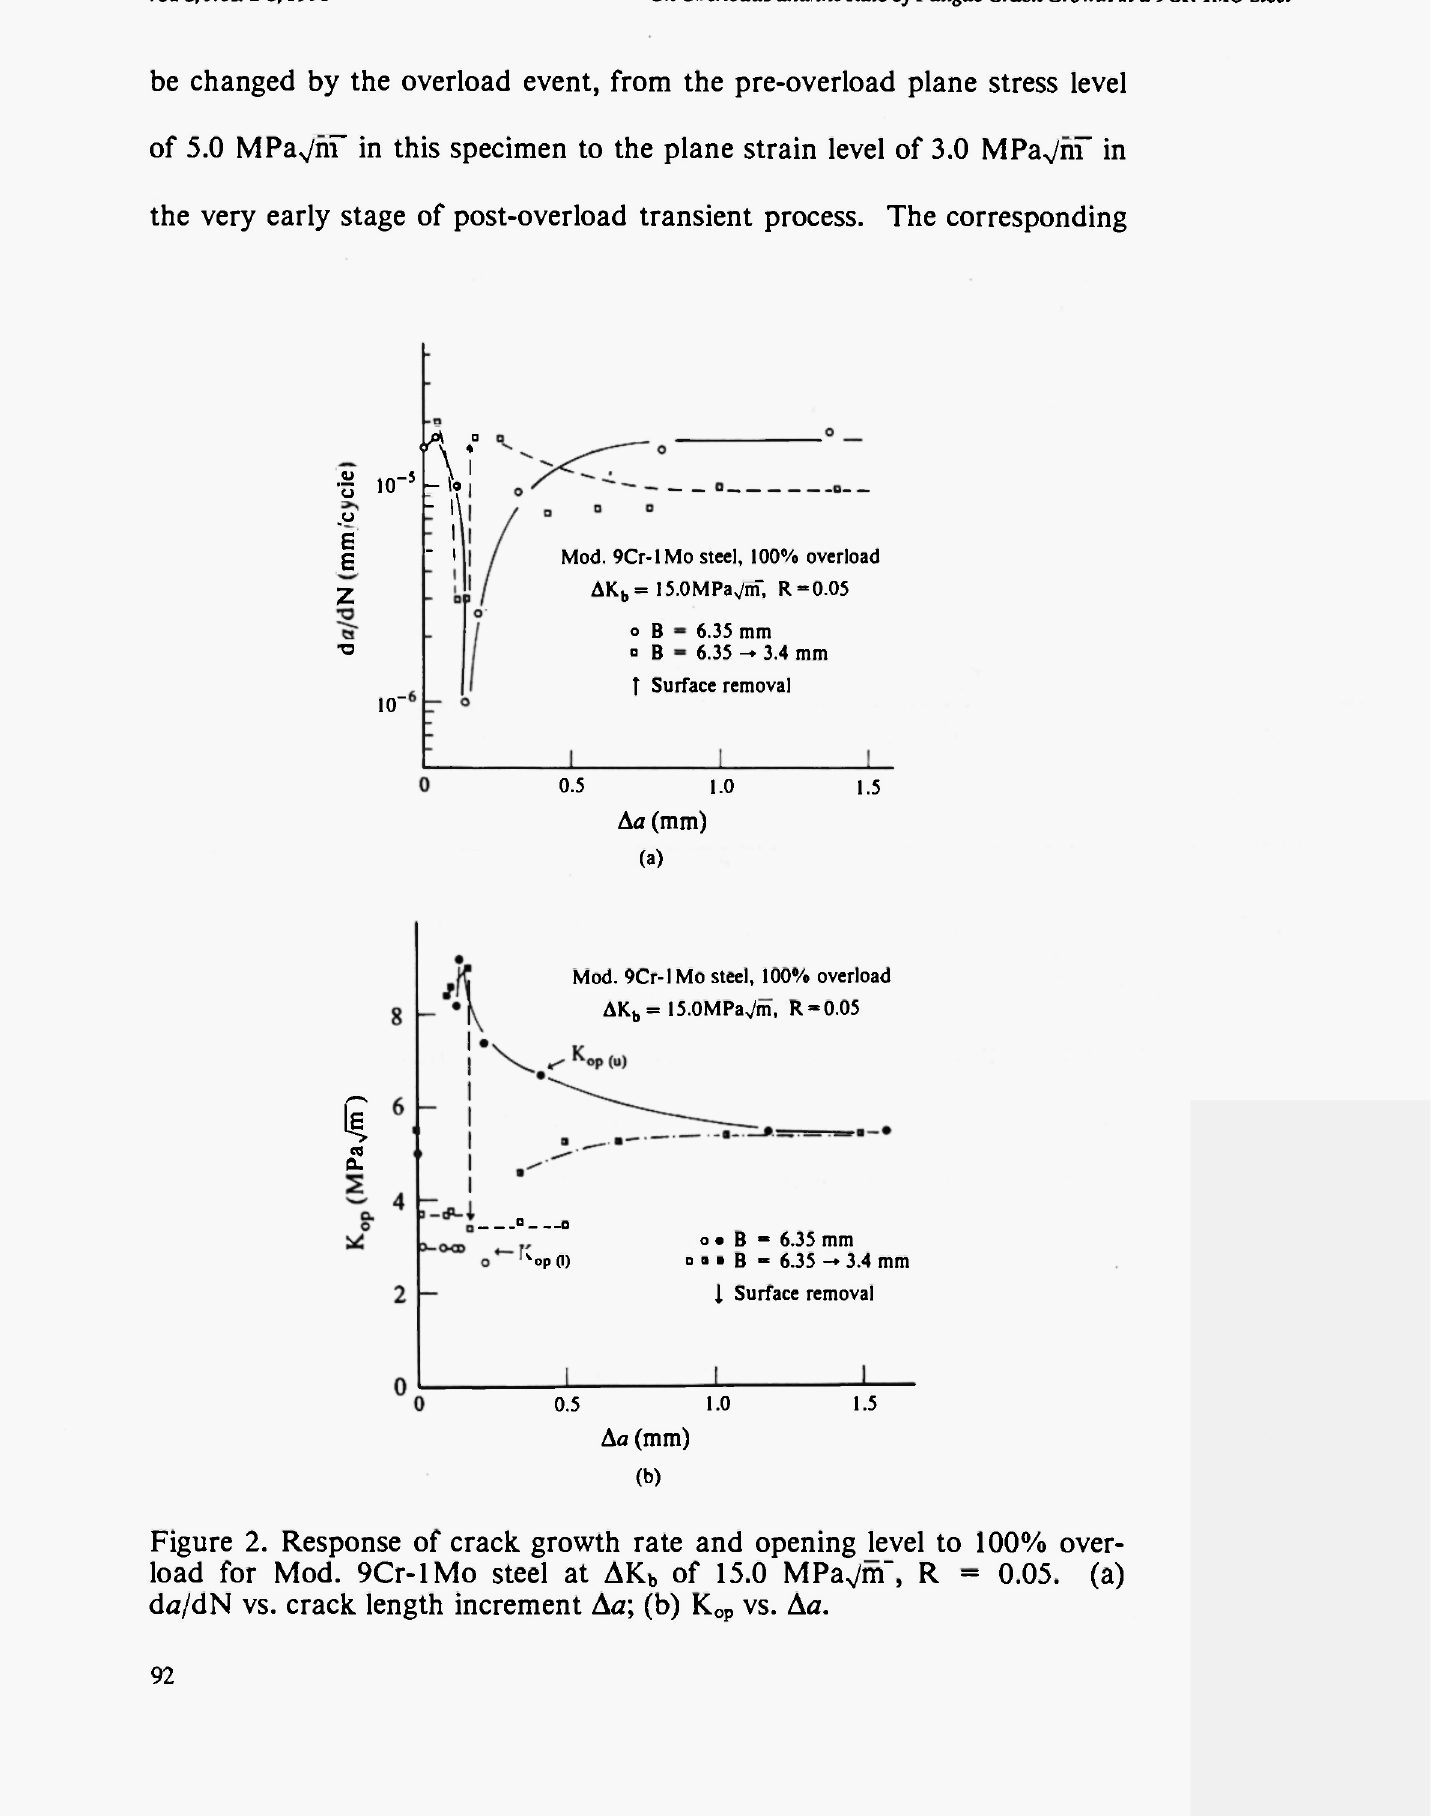
Figure 2. Response of crack growth rate and opening level to 100% over- load for Mod. 9Cr-lMo steel at ΔΚ„ of 15.0 MPa^m", R = 0.05. (a) da/dN vs. crack length increment Δα; (b) K